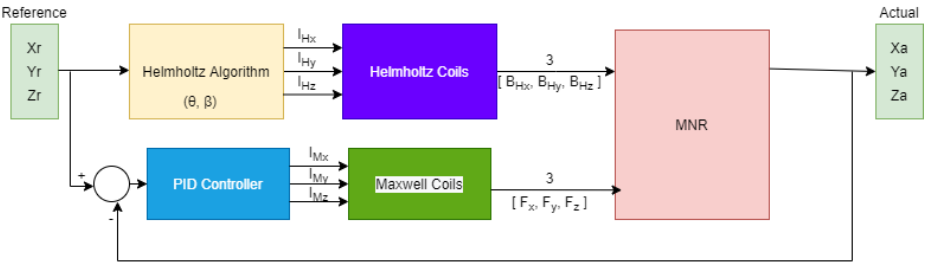
Figure 7. Block diagram representing the actuation control algorithm.